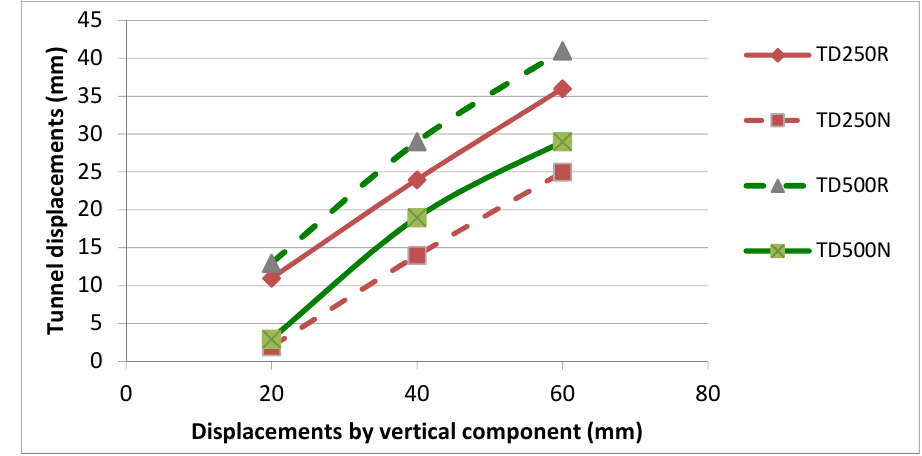
Figure 11. The effect of tunnel depth in normal and reverse faults. Figure 11. The e ff ect of tunnel depth in normal and reverse faults.